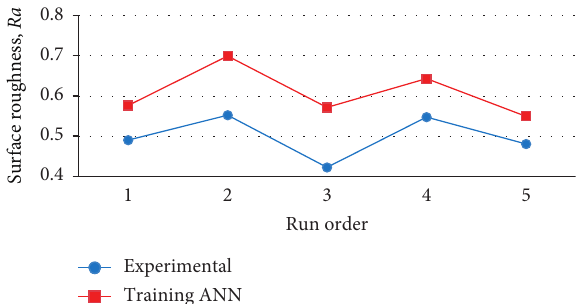
Figure 3: Matching of experimental and ANN values for surface roughness testing sets.